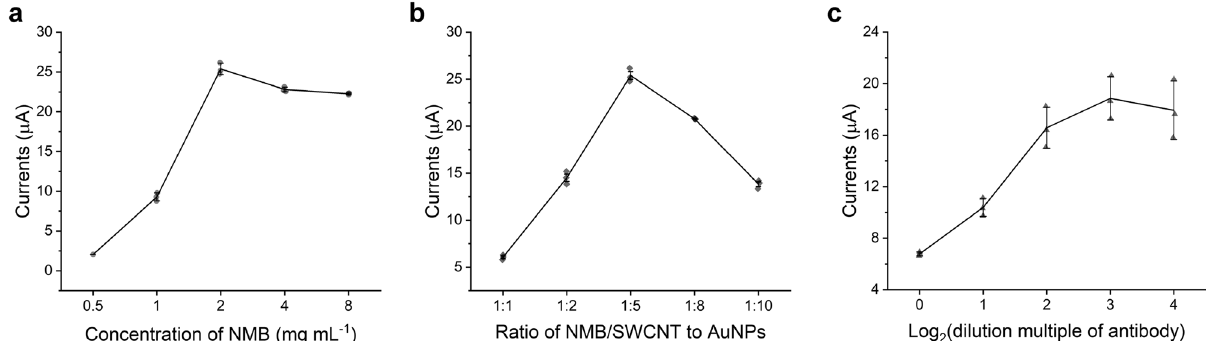
Fig. 3 Optimization process of the VEGF-C immunosensor. a Effects of different concentrations of new methylene blue, the best concentration of NMB was 2 mg mL − 1 . b Effects of the proportion of NMB/SWCNT to AuNPs, the best ratio of NMB/SWCNT to AuNPs was 1:5. c In fl uence of the dilution multiple of the VEGF-C antibody, the best concentration of the VEGF-C antibody was 0.125 μ g mL − 1